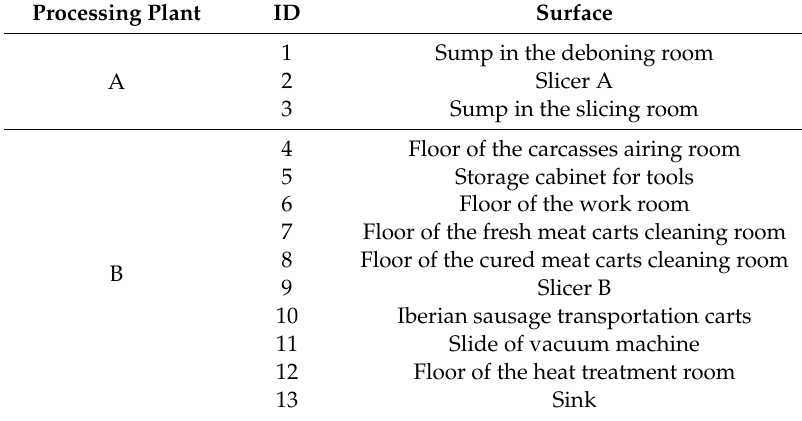
Table 1. Work surfaces from Plants A and B where the SCH sensors were installed (coded from 1 to 13)